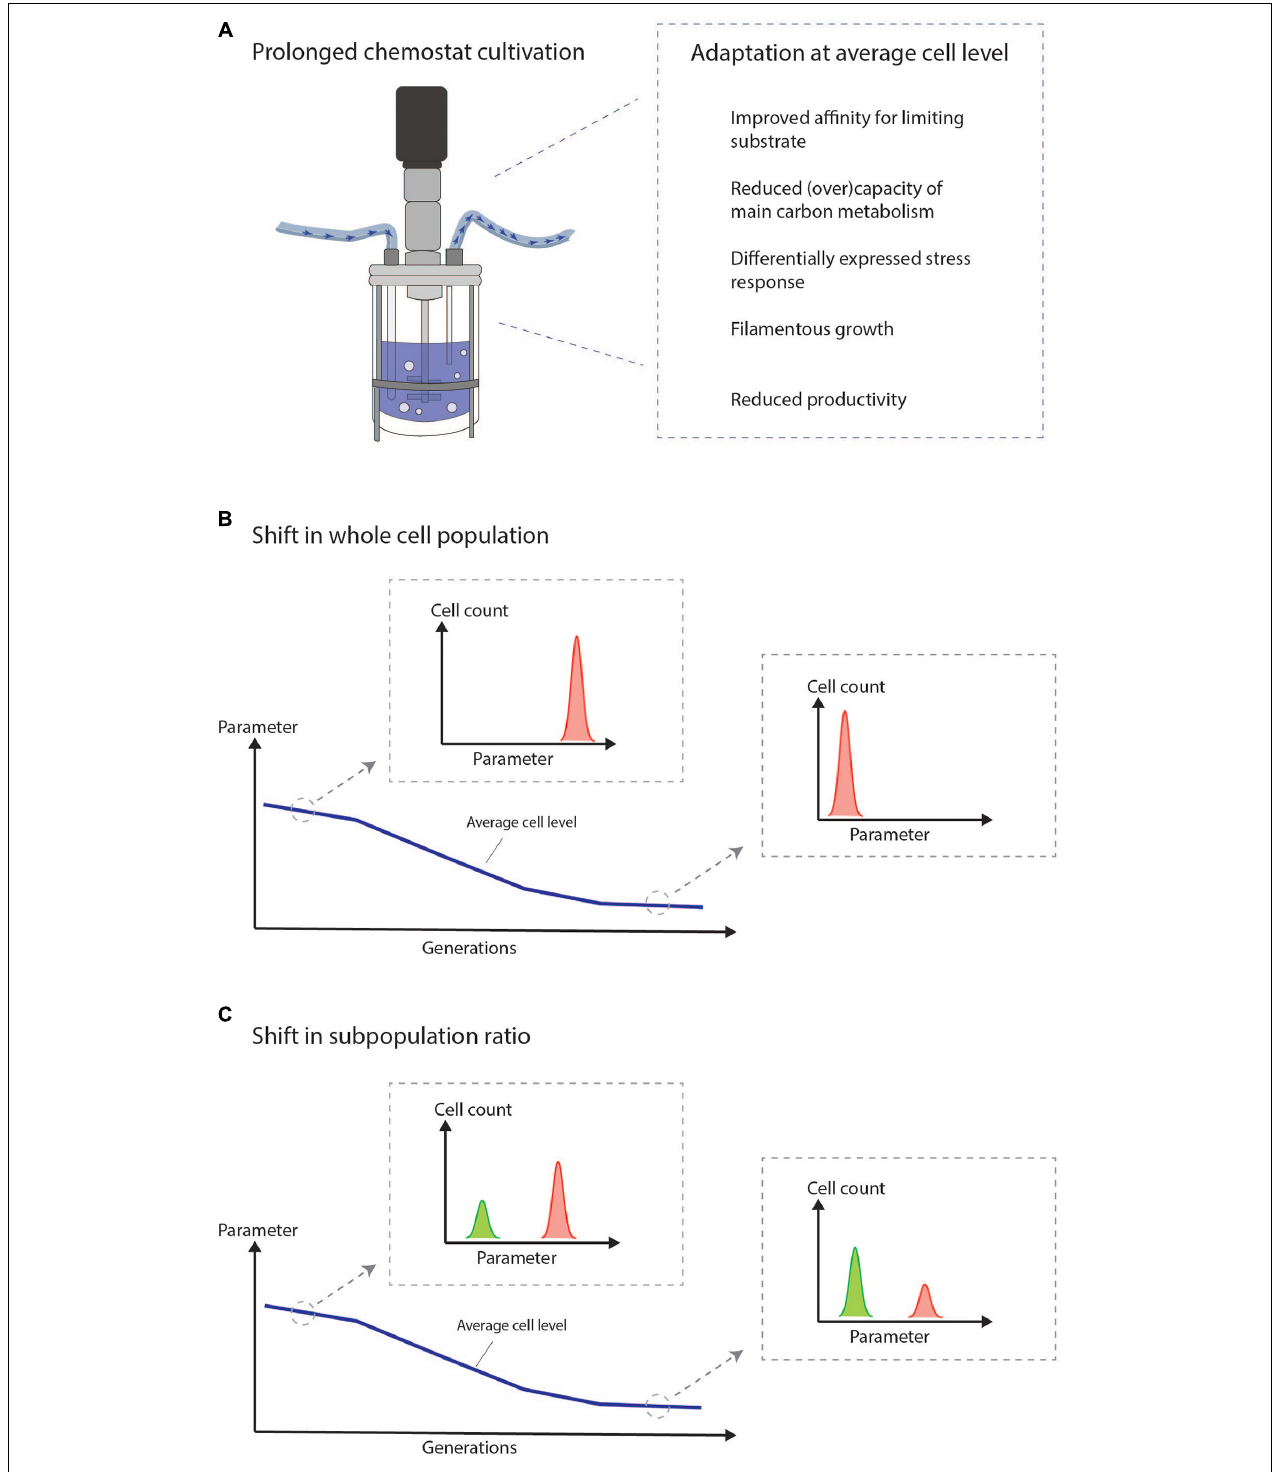
FIGURE 1 | The chemostat imposes a selective pressure on the cultured cells, which drives cellular adaptation. We suggest to intensify the efforts on combining the study of adaptation at the average cell level with the current knowledge of population heterogeneity in chemostats to study the mechanisms of adaptation at the single cell level. (A) General trends observed at average cell level during prolonged adaptation in chemostat cultivation of microbes. (B) Illustration of adaptation measured in the bulk. The figure illustrates how it may look at the single-cell level if the adaptation is a result of a shift in the whole cell population. (C) Illustration of adaptation measured in the bulk. The figure illustrates how it may look at the single-cell level if the adaptation is a result of a shift in subpopulation ratios.